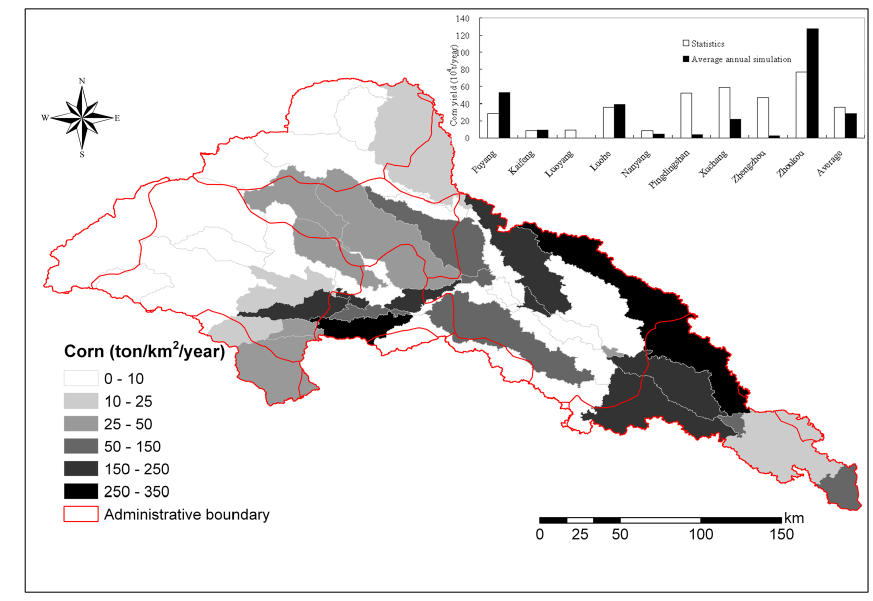
Figure 11. The spatial pattern of corn yield at the sub-basin and regional scale in the Shaying River catchment.